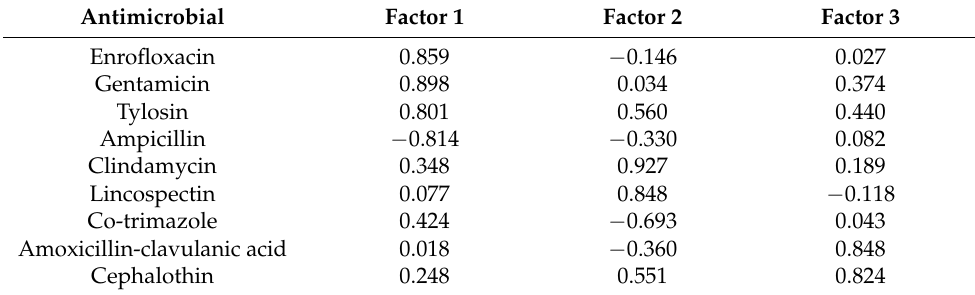
Table 4. Loading factors.